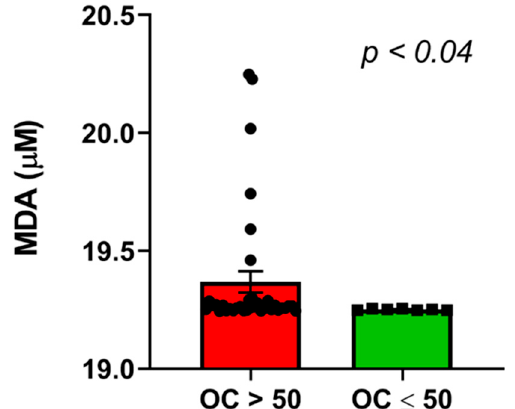
Figure 6. Graphical representation comparing malondialdehyde level in high and low overcommitted nurses. Malondialdehyde (MDA) was measured in the urine samples of the study participants and compared (OC > 50 vs. OC ≤ 50; p < 0.04) using Mann–Whitney test.